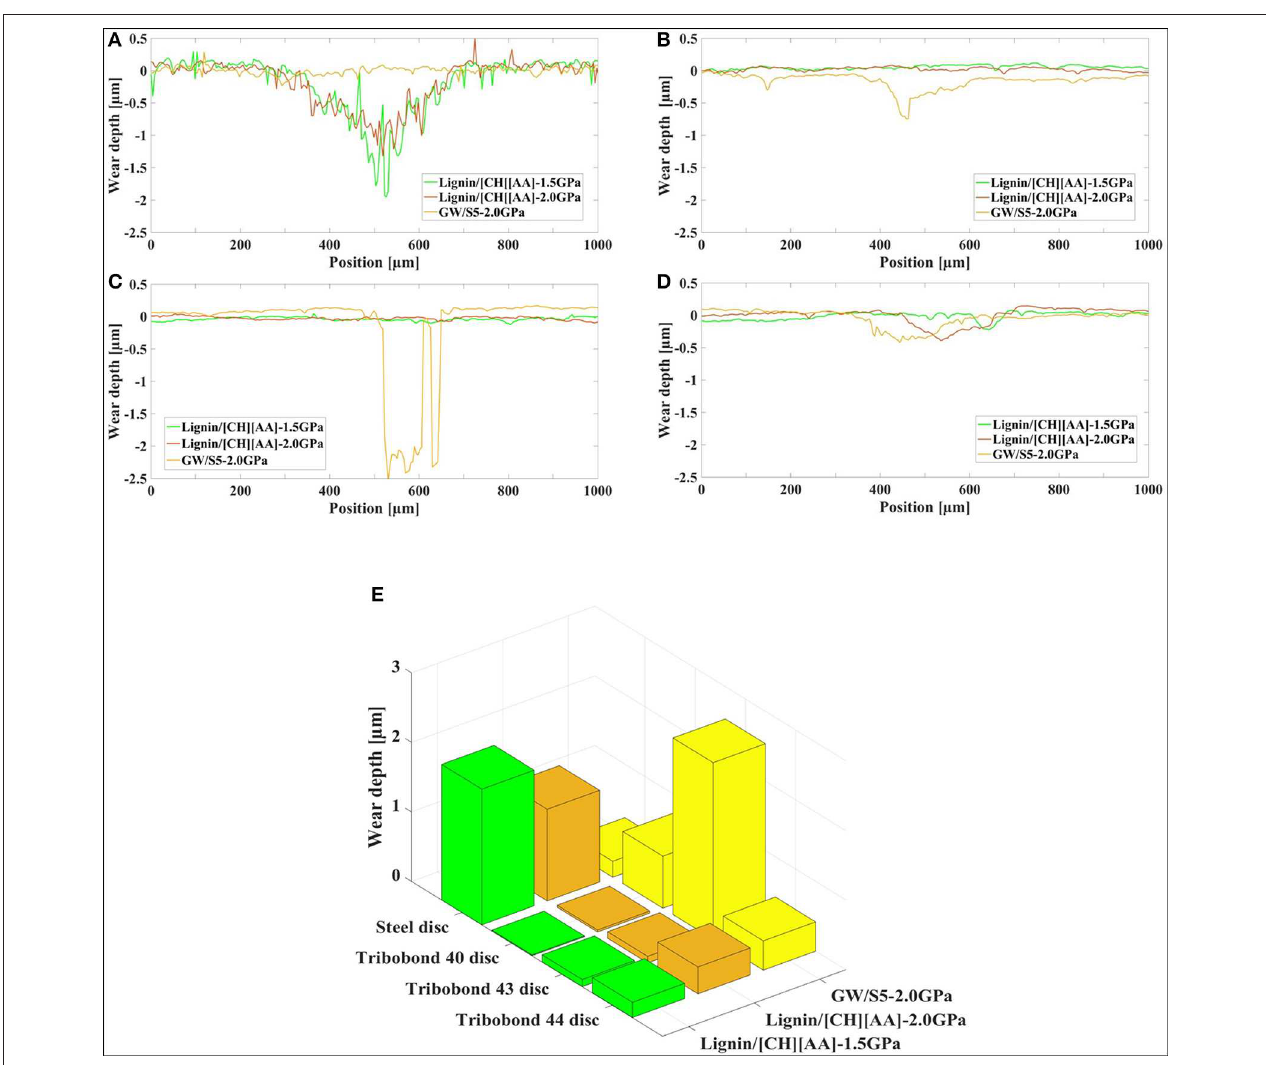
FIGURE 4 | Cross-sectional profile of typical worn surface: (A) steel disc, (B) Tribobond 40 disc, (C) Tribobond 43 disc, (D) Tribobond 44 disc; (E) Comparison of wear depth.